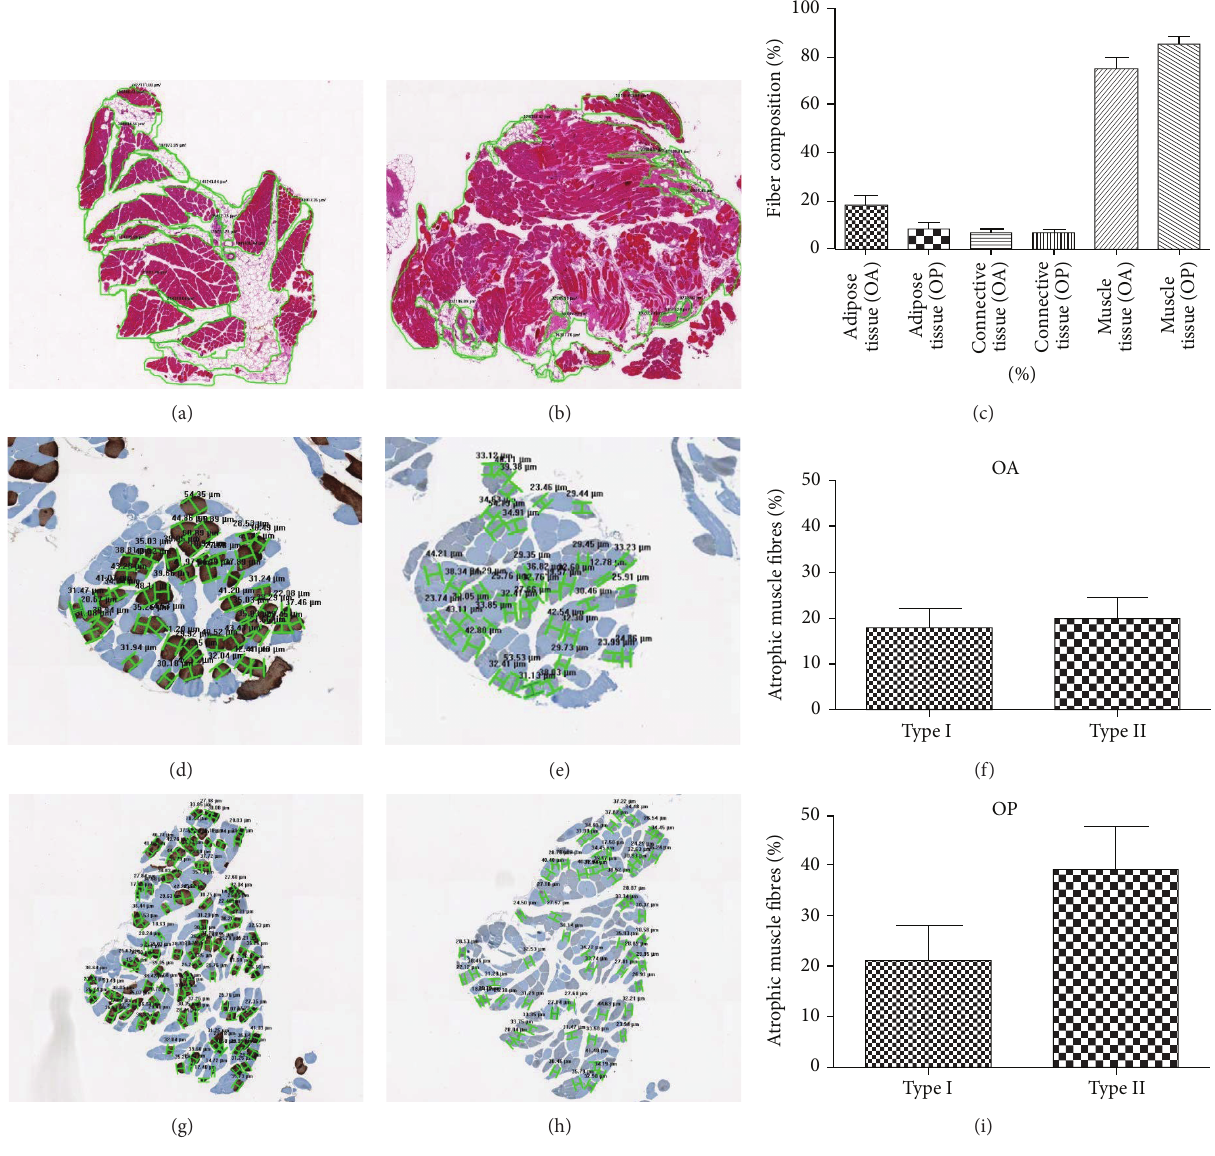
Figure 1: Muscle fibers composition and atrophy. ((a), (b), and (c)) In OA patients the rate of muscle loss was replaced mainly by adipose tissue (18.32%), whereas in OP muscle fasciculus atrophic muscle fibers were substituted by adipose (8.27%) and connective tissue (6.68%). ((d), (e), (f), (g), (h), and (i)) In OA patients we did not observed significant differences in fibers type atrophy, whereas In OP group we observed more than 50.00% of atrophic fibers with prevalence of type II fibers (21.10% type I and 39.20% type II).